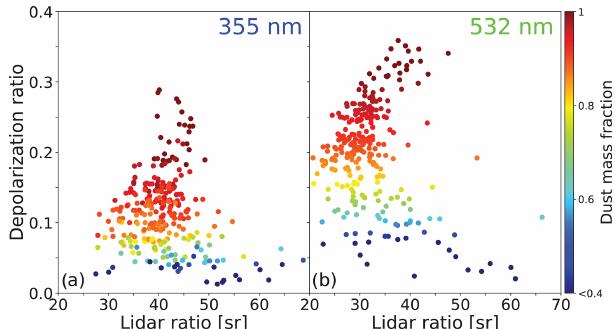
Figure 7. Correlation between the extinction-related Ångström ex- ponent (355–532nm) and (a) the 355 and 532nm particle linear depolarization ratios and (b) the 355 and 532nm particle lidar ra- tios.